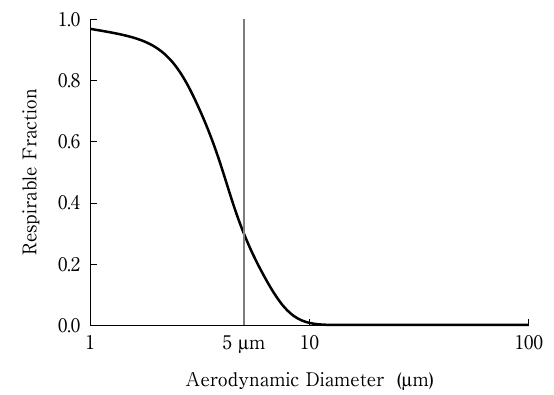
Aerodynamic Diameter ( Fig. 3 Respirable fractions of particles with different aerodynamic di- ameters.